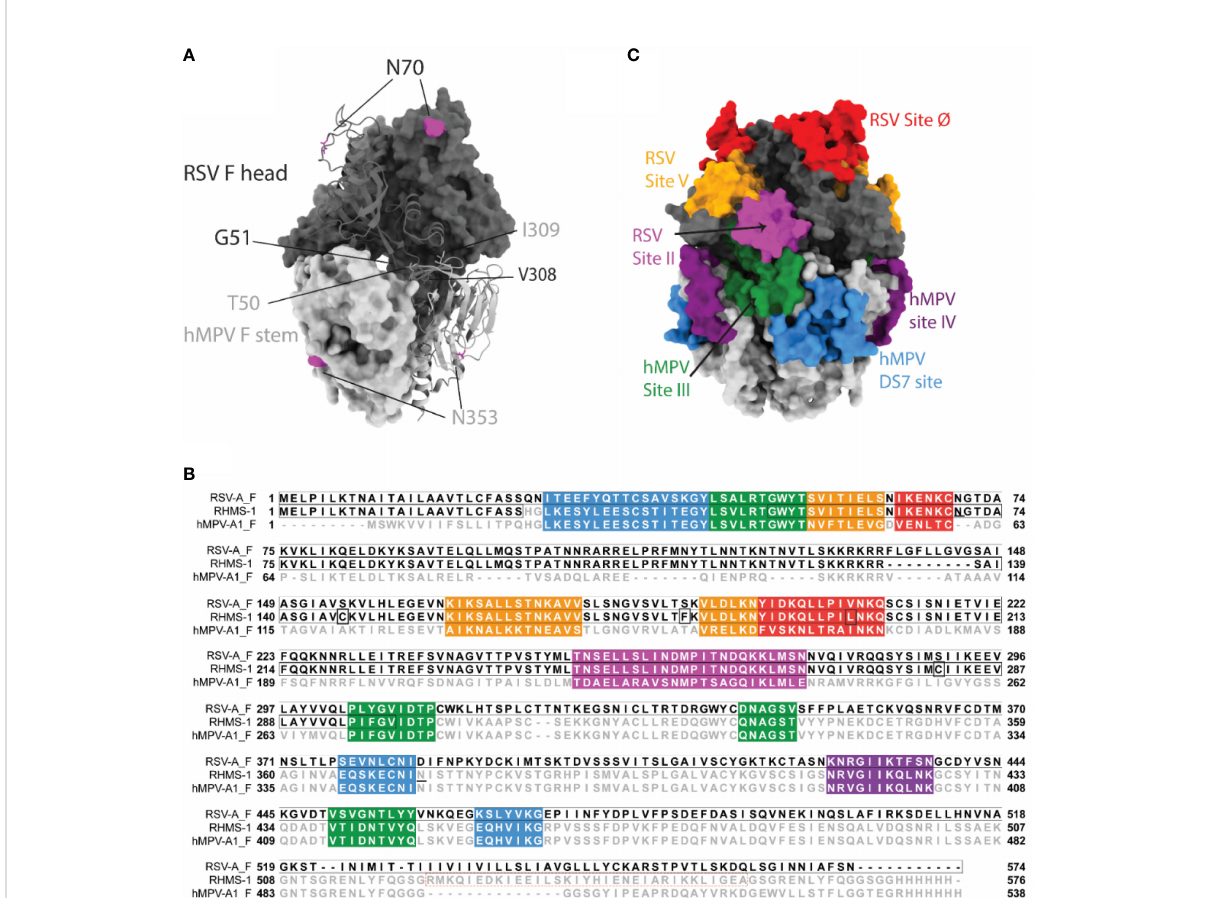
FIGURE 1 RHMS-1 protein design. (A) The diagram generated with the head (gray) of pre-fusion RSV F (5UDE) and the stem (silver) of pre-fusion hMPV F (5WB0) shows one protomer in cartoon and the rest of two protomers in surface. The glycosylation sites are shown in magenta. (B) Sequence alignment of RSV-A F, RHMS-1, and hMPV-A1 F generated by Jalview. The sequences of known antigenic sites are highlighted: RSV site Ø – red, RSV site V – orange, RSV site II – magenta, hMPV site III – forest, hMPV site IV – purple, hMPV DS7 site – blue. In RHMS-1 sequence, four Ds- Cav1 mutations are circled in boxes, two N-linked glycosylation sites are underlined and the GCN4 trimerization domain is circled in red dashed box. (C) The antigenic sites colored in accordance with the sequences highlighted in Figure 1B are displayed on the diagram. Both fi gure 1A and C were made by